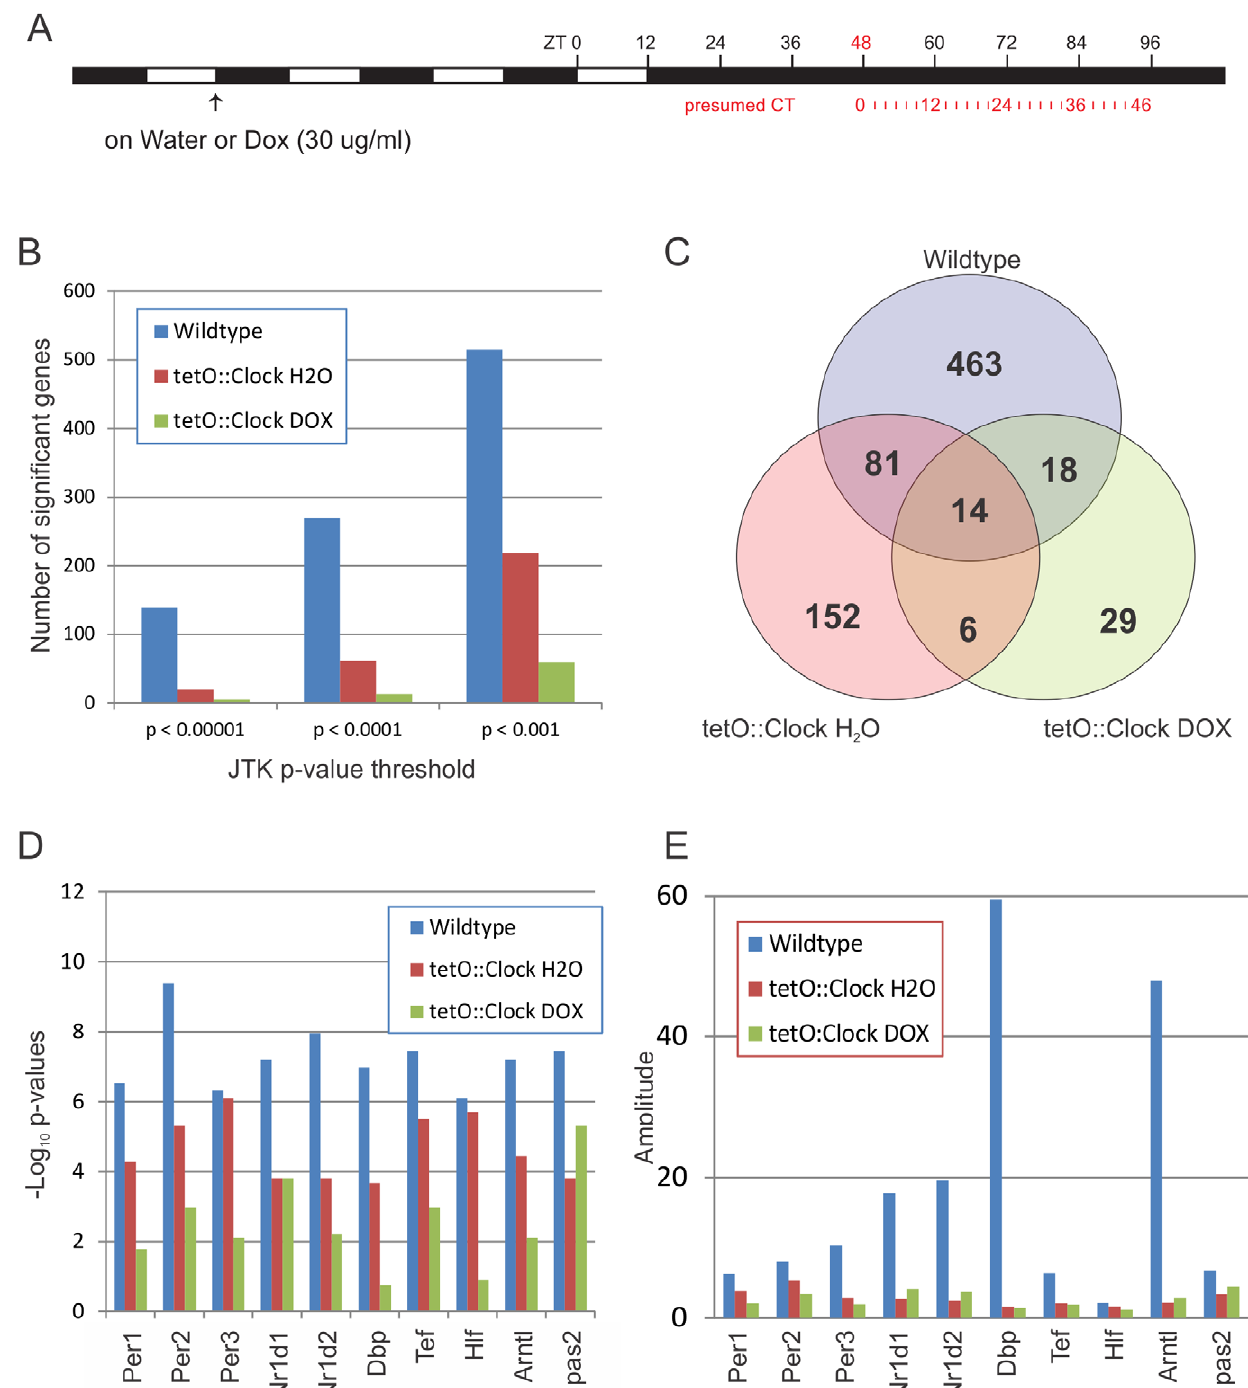
Figure 2. Brain-specific rescue of Clock partially restores transcriptional circadian output in the liver. (A) Wildtype and Clock -expressing mice ( Scg2::tTA;tetO::Clock WT ; Cl D 19 /Cl D 19 ) were entrained to a 12 h:12 h light:dark (LD) cycle and then treated with either H 2 O or doxycycline (Dox, 30 m g/ml) 3 days before releasing the mice to constant darkness. Liver samples were collected every two hours for two complete days, starting 48 hours after the final lights-on. (B–E) Cycling genes were detected in microarray datasets using JTK_Cycle. At every p-value threshold tested (B), wildtype livers show considerably more cycling genes than Clock -mutant mice ( tetO::Clock DOX), while the Clock -rescue animals ( tetO::Clock H2O) have an intermediate number of rhythmic genes. Panel (C) shows the number of cycling genes overlapping between the different genotypes/ treatments at a p-value threshold of p , 0.0011 (corresponding to q , 0.05 in wildtype, all period lengths between 10 and 40 hours). The strength of rhythmicity of core clock genes and key circadian output genes (as measured by 2 Log 10 p-values) is generally higher in Clock -rescue animals ( tetO::Clock H2O) versus the Clock -mutants ( tetO::Clock DOX). (D) However, Clock -rescue ( tetO::Clock H2O) does not restore wildtype-levels of circadian amplitude in most of these genes (E).